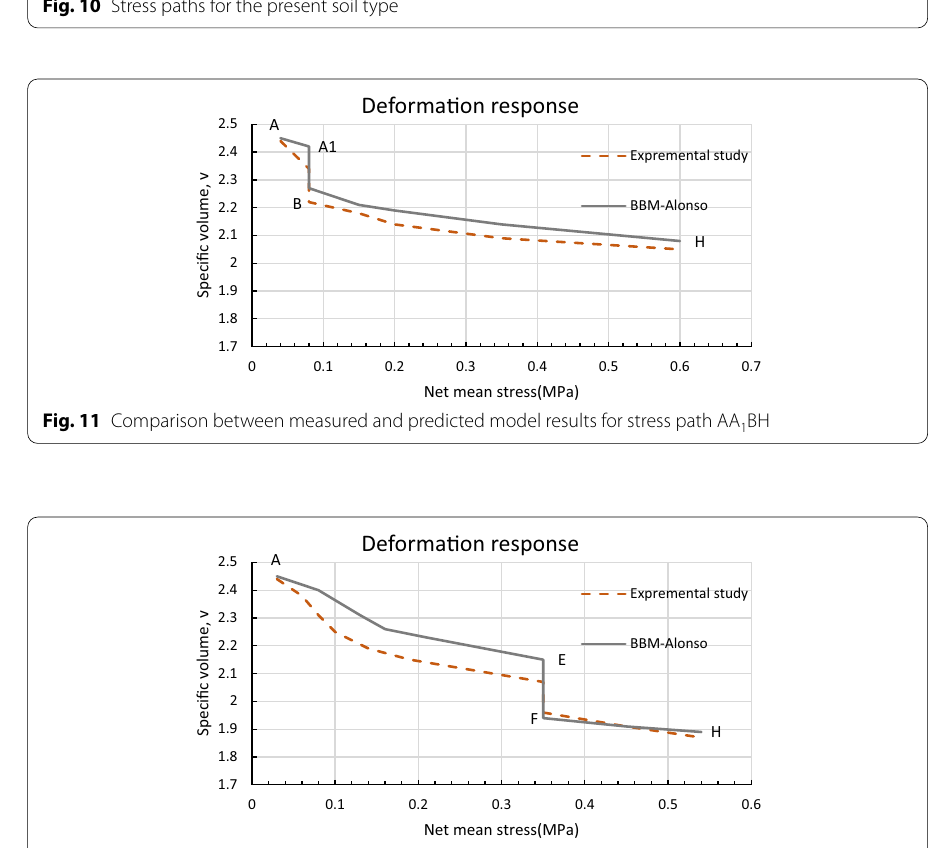
Fig. 12 Comparison between measured and predicted model results for stress path